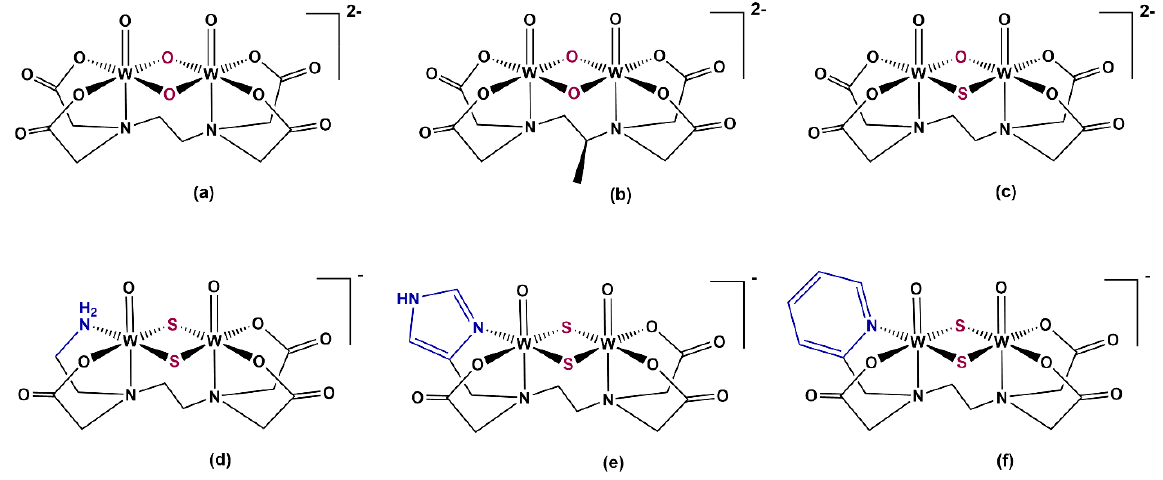
Figure 1. Chemical structures of bis-anionic [W 2 O 2 (µ-O) 2 (EDTA)] 2- ( a ) [15], [W 2 O 2 (µ-O) 2 ( R -PDTA)] 2 − ( b ) [17], [W 2 O 2 (µ-O)(µ-S)(EDTA)] 2 − ( c ) [18], and the monoanionic sulfido-bridged analogs ( d − f ) [20]. Counterions comprise Na + or K + . EDTA: ethylenediaminetetraacetate, R -PDTA: ( R )- propylenedia-